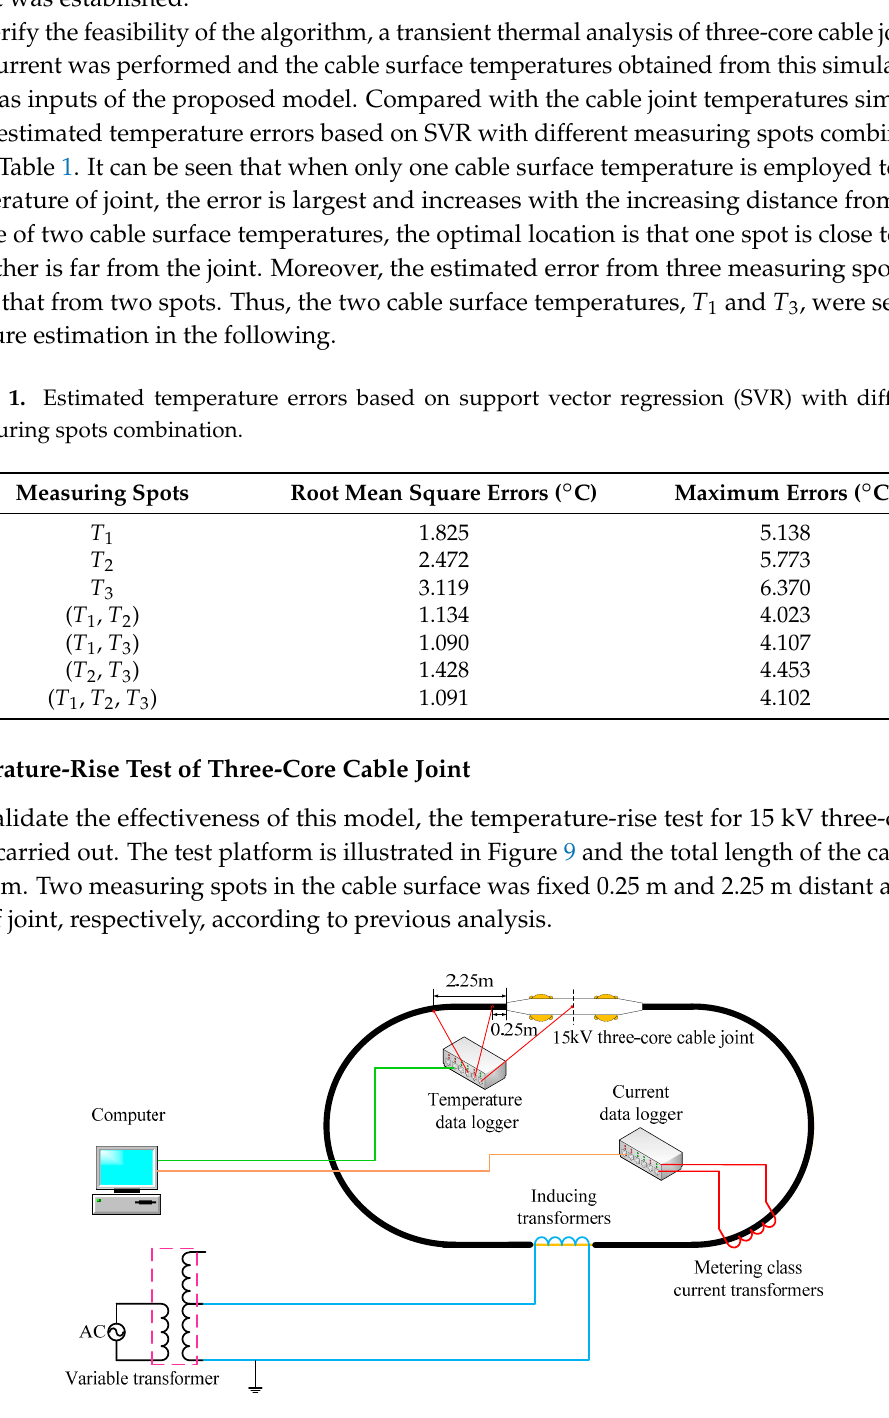
Figure 9. Schematic diagram of the temperature rise test platform.